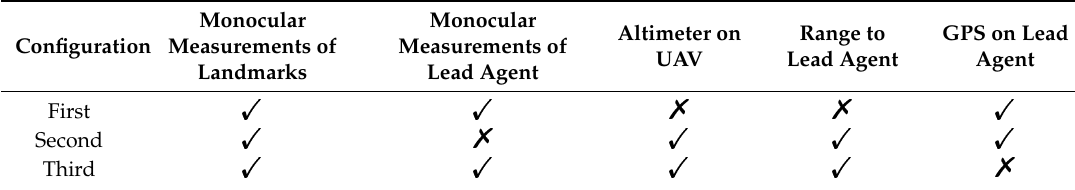
Table 1. System configurations